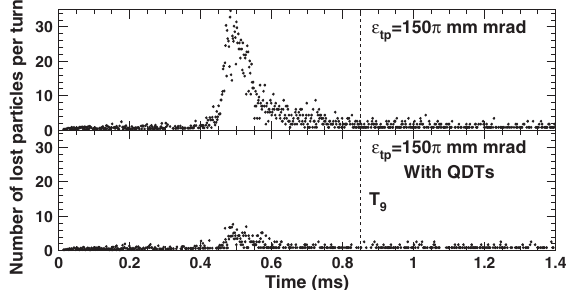
FIG. 17. Numerical simulation results corresponding to the experimental data in Fig. 16.